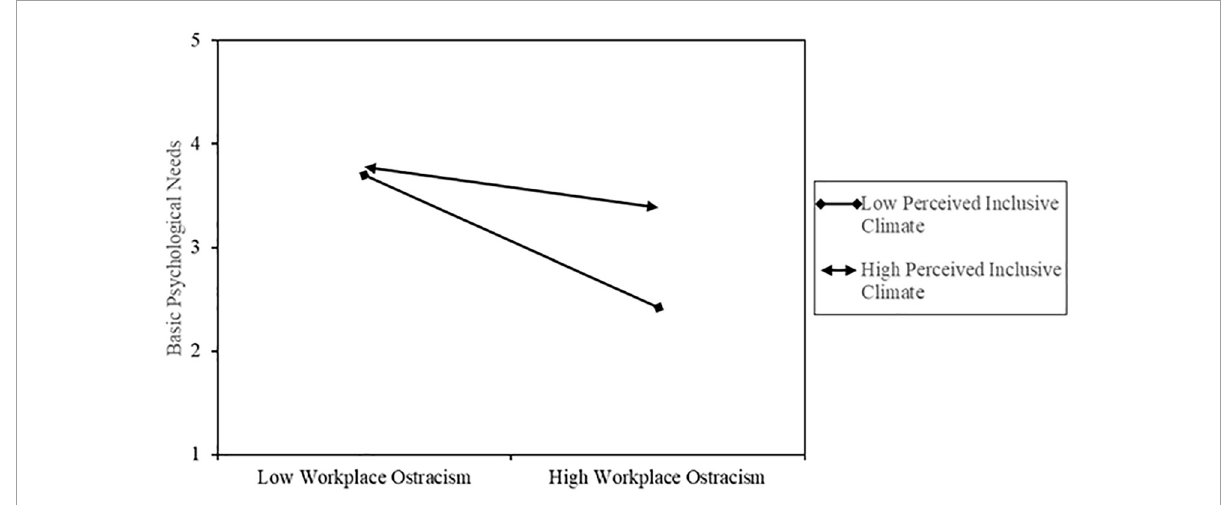
FIGURE2 The interactive effect between workplace ostracism and perceived climate for inclusion on basic psychological